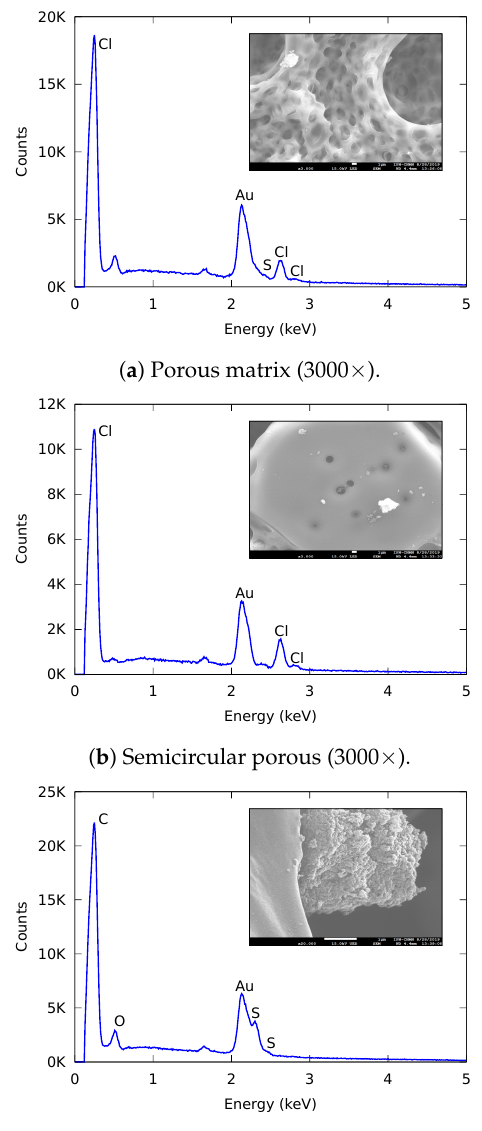
Figure 7. EDS analysis results for the